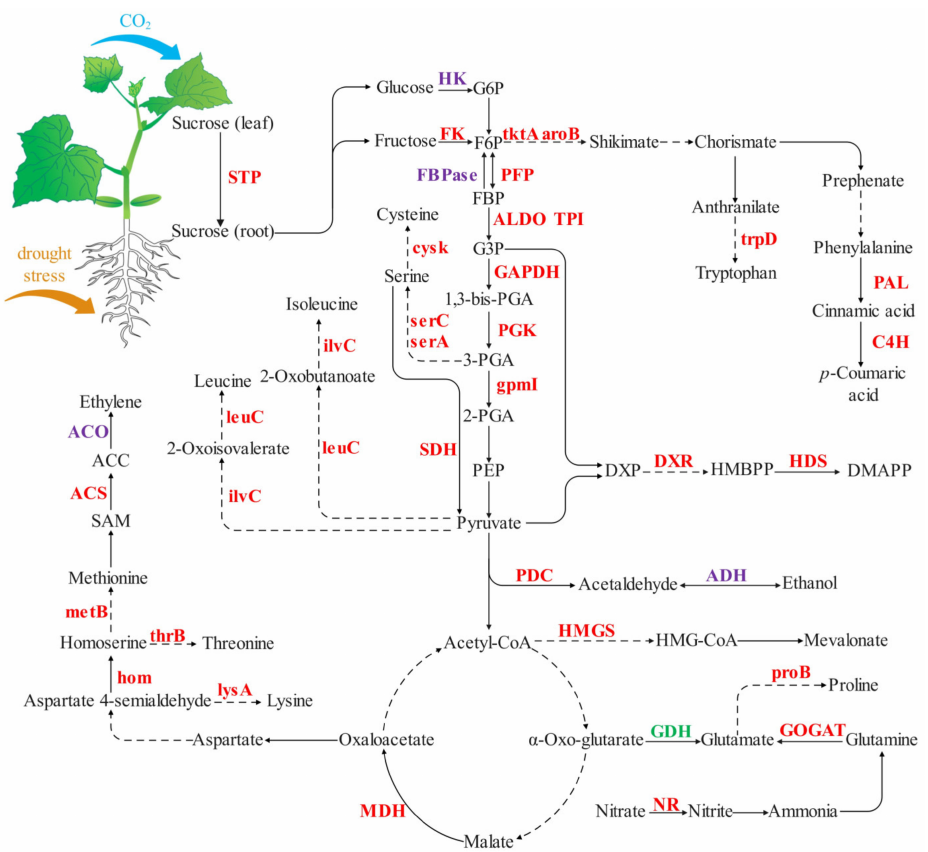
Figure 9. The main differentially accumulating proteins (DAPs) of cucumber seedling root response to [CO 2 ] enrichment under drought stress. Black words indicate metabolites, arrows indicate metabolic processes, and omitted processes are indicated by dashed lines. Red words indicate the upregulated DAPs under moderate drought stress after [CO 2 ] enrichment, green words indicate the downregu- lated DAPs under moderate drought stress after [CO 2 ] enrichment, and purple words indicate the upregulated DAPs under both moderate and severe drought stress after [CO 2 ] enrichment.